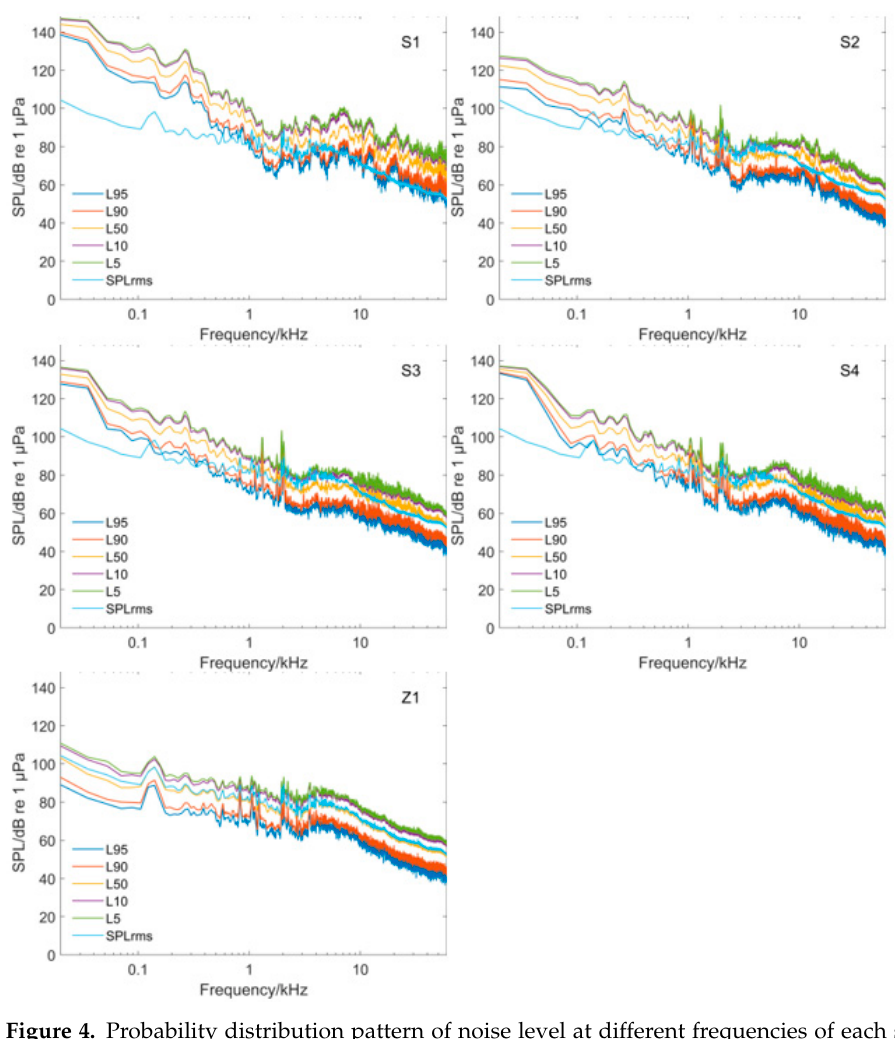
Figure 4. Probability distribution pattern of noise level at different frequencies of each sampling point (frequency range 20 Hz − 60 kHz).